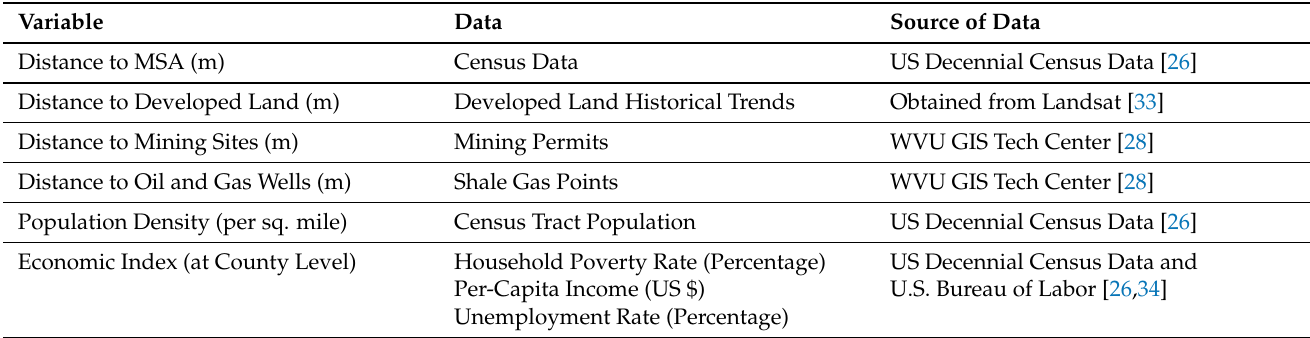
Table 1. Studied